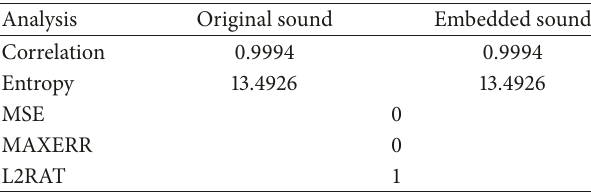
between the original and embedded sound data seen in Table 4: Security analysis of the steganography